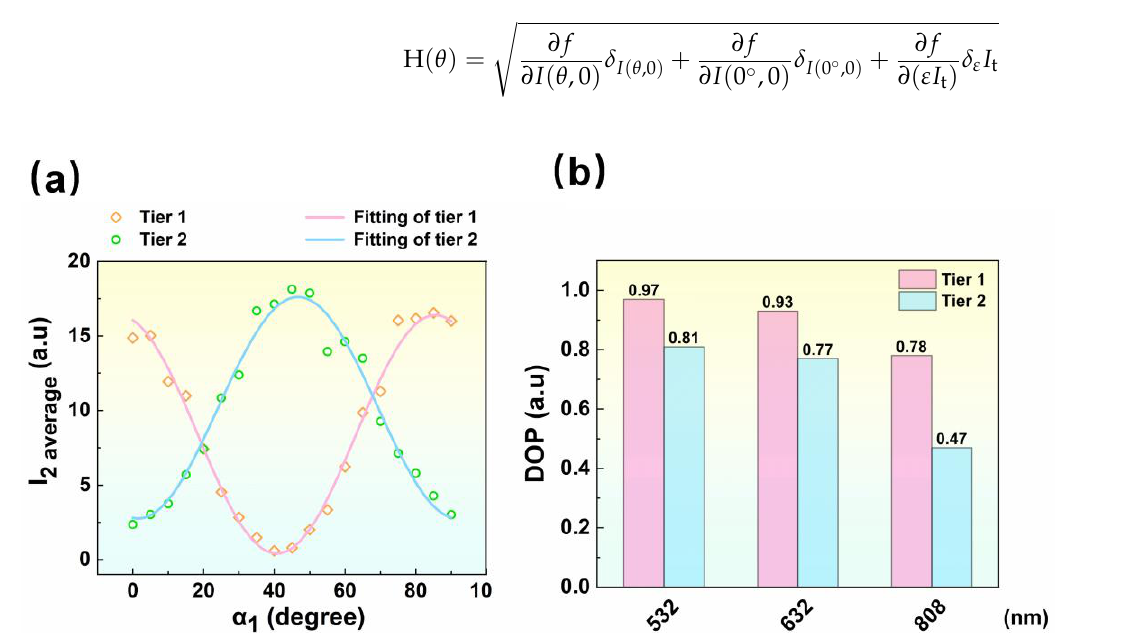
Figure 5. ( a ) The light intensities of CNT pixels, along with the changes in polarizing angle ( α 1 ), are depicted in tier 1 and tier 2. The fittings of both tiers are demonstrated, which follow Malus’ law and show a phase offset of ~39 degrees. ( b ) The DOP of pixels in both tiers is measured at three wavelengths of laser, which are 532 nm, 632 nm, and 808 nm.